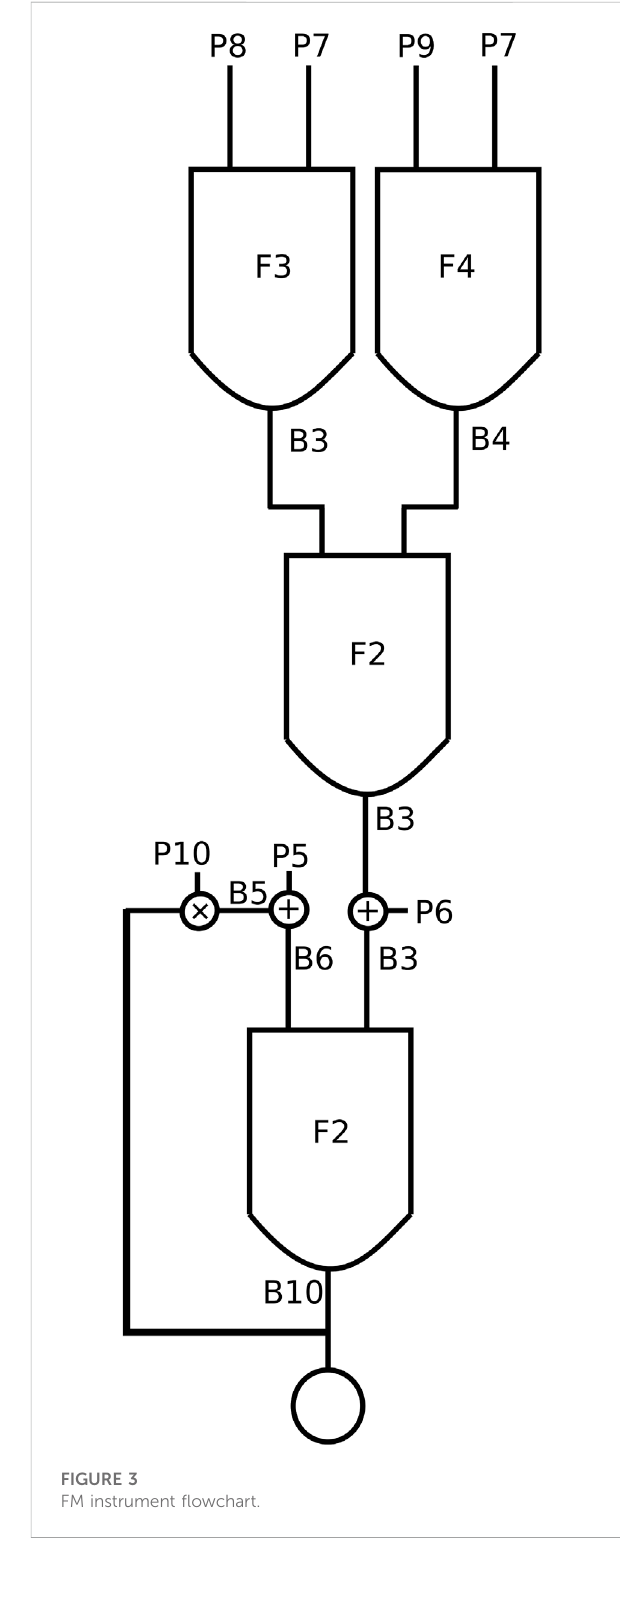
FIGURE 3 FM instrument fl